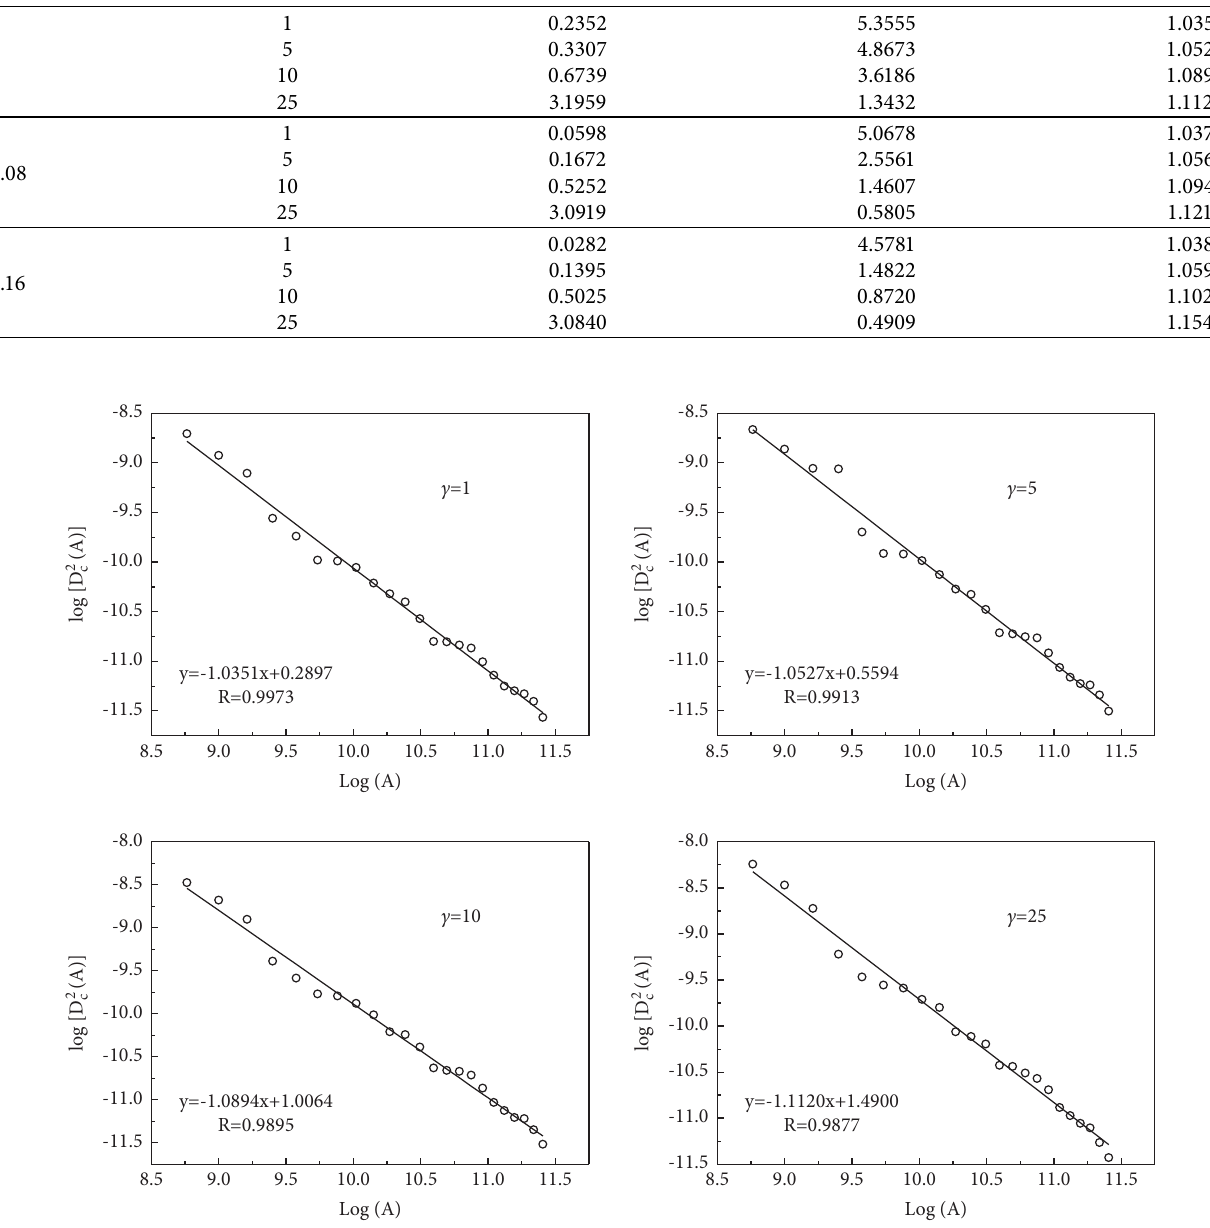
Figure 8: Parameter ftting results for diferent c values ( k �